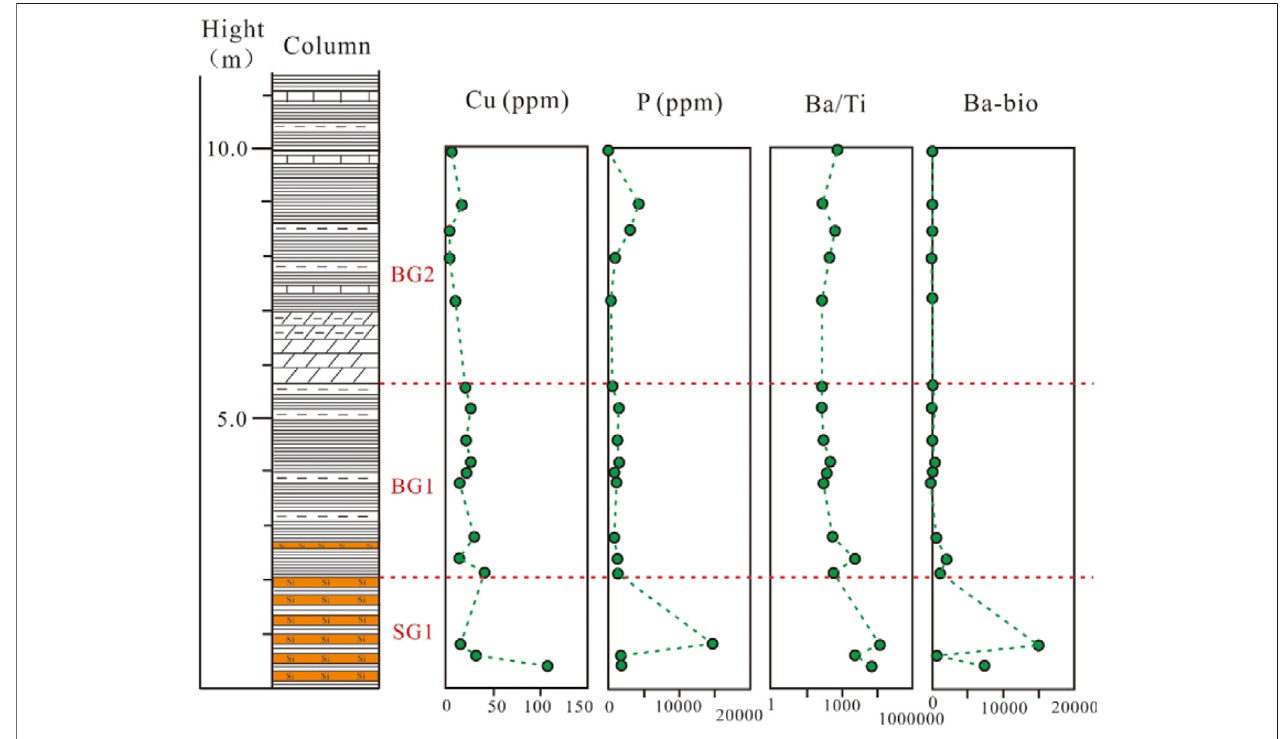
FIGURE 4 | Variations of Cu, P, Ba/Ti, and Ba-bio with